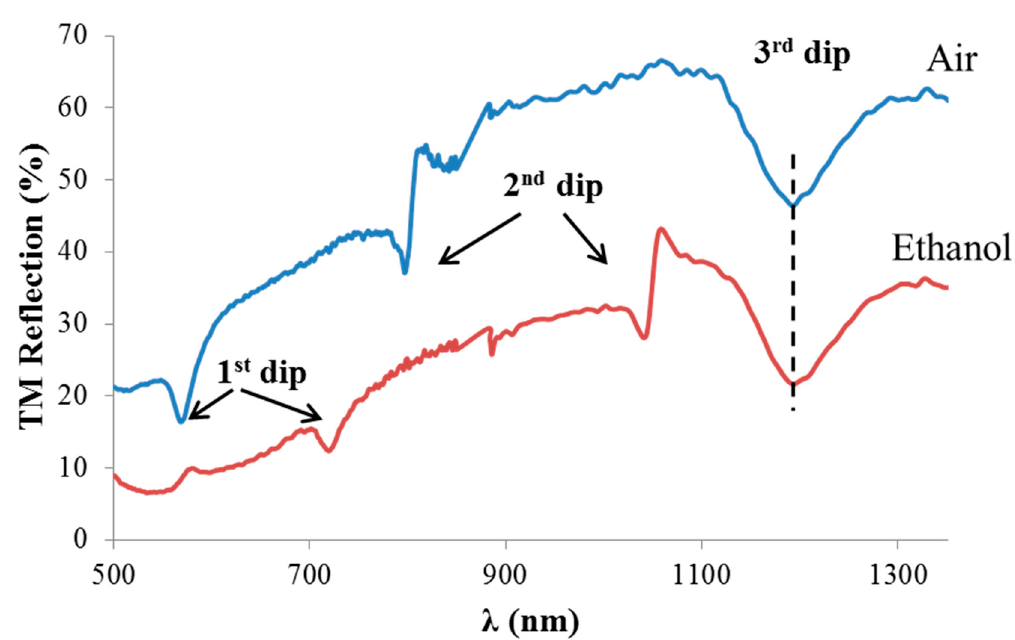
Figure 20. Observation of resonant dips in the IR spectral range showing the potential of sensing operation in the IR using CD-R.